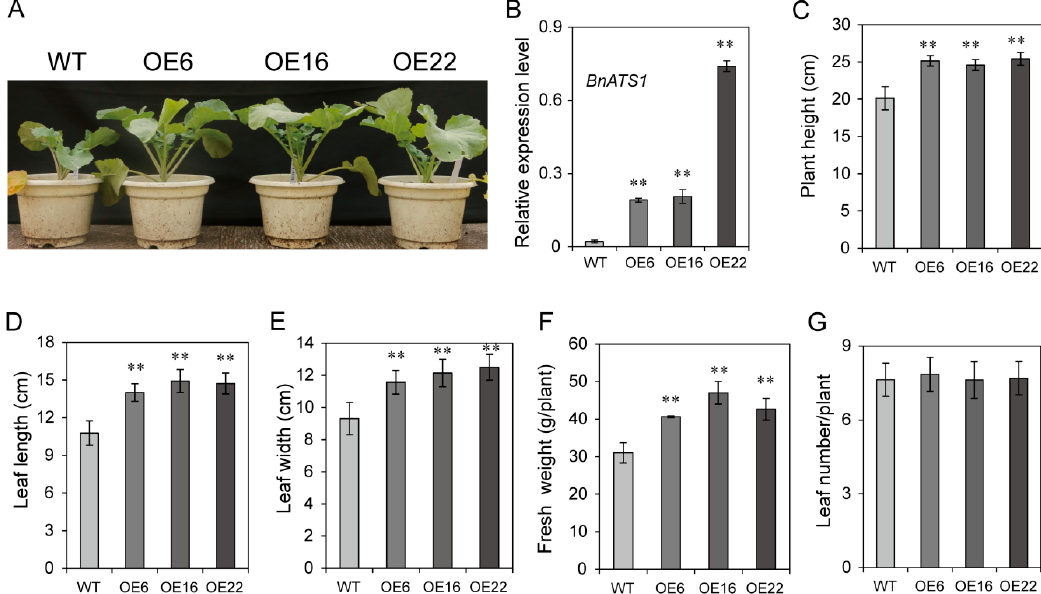
Figure 3. Overexpression of BnATS1 promoted plant growth at the vegetative stage. ( A ) The growth phenotype. ( B ) BnATS1 was overexpressed in cv. Westar plants as compared with the wild type (WT) plants detected by RT-qPCR. Total RNA was extracted from leaves of plants at the vegetative stage. β -Actin from Brassica napus was used as an internal standard. Values are mean ± SD ( n = 3 separate samples). ( C ) Plant height, ( D ) leaf length, ( E ) leaf width, ( F ) fresh weight of aboveground parts, and ( G ) leaf number of 26-day-old plants under field growth conditions. The leaf size was measured in the top 1st and 2nd leaves fully expanded in 26-day-old plants. The plant height represents the length of aboveground parts. Values are means ± SD ( n = 5 independent experiments). ** indicates significant difference at p < 0.01 compared with the WT based on Student’s t test.